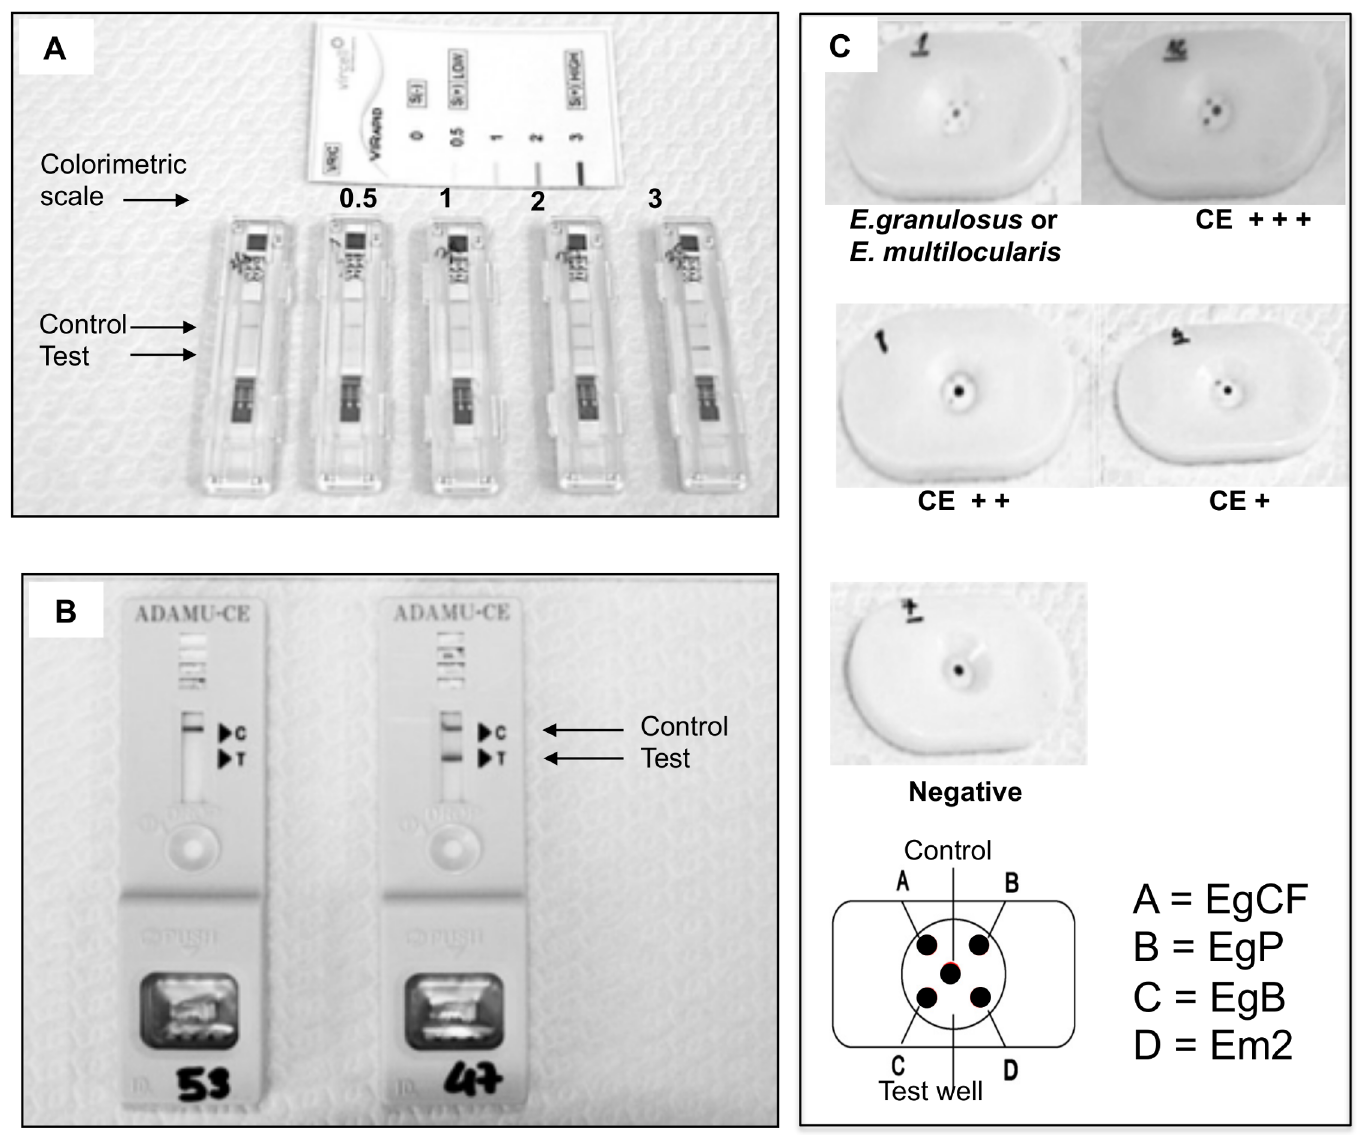
Fig 1. Examples of RDTs results. (A) VIRapid HYDATIDOSIS test and its semiquantitative colorimetric scale. (B) ADAMU-CE test. (C) DIGFA test and its diagnostic and semiquantitative colorimetric interpretation; EgCF = E . granulosus Cyst Fluid antigen, EgP = E . granulosus Protoscolex antigen, EgB = E . granulosus antigen B, Em2 = E . multilocularis antigen